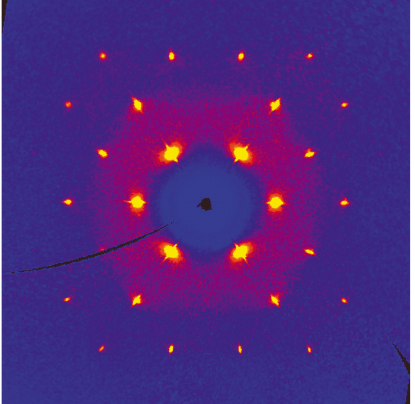
Figure 2 Reciprocal space of the plastic phase of cyclohexane, at 255 K, viewed in a projection normal to [011]. Direction [100] runs on the right, direction [011] runs upward.